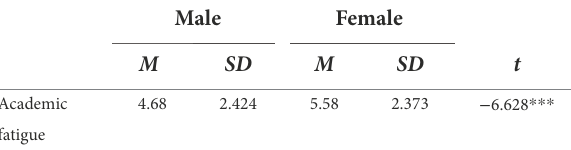
TABLE 6 T -test of academic fatigue among male and female college